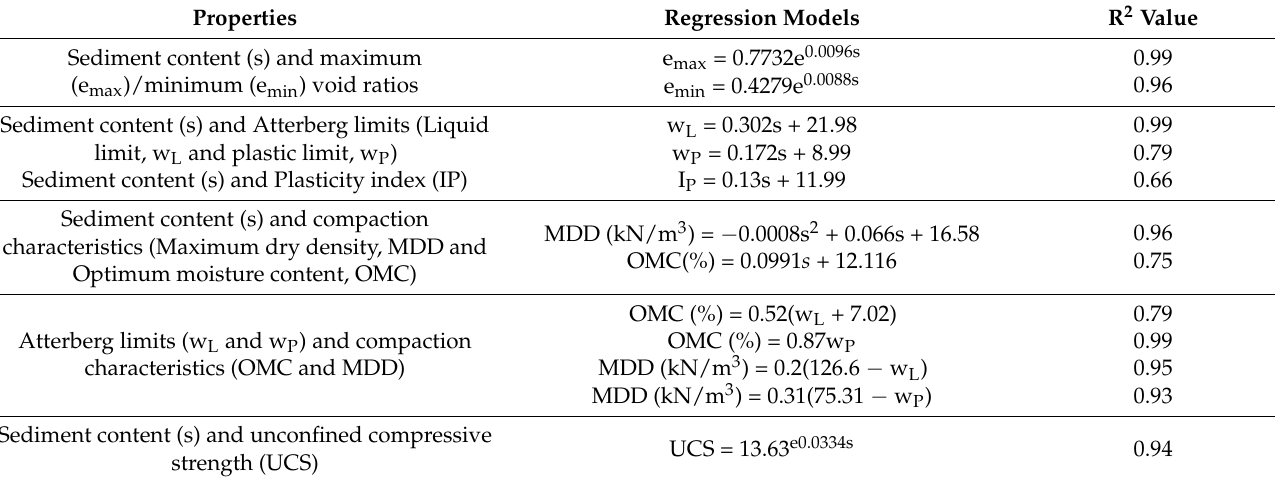
Table 4. List of important regression models